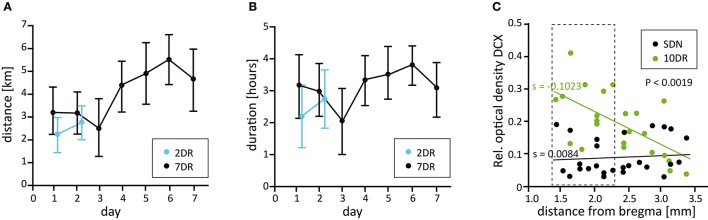
Running parameters and analysis of neurogenesis along the septotemporal axis. (A) Mean daily running distance of the 2 day (2DR, blue, N = 14) and the 7 day running groups (7DR, black, N = 18). Values are given as mean ± 95% confidence interval (CI). (B) Mean daily running duration for the 2DR (blue) and 7DR groups (black, mean ± 95% CI). (C) Densitometric analysis of DCX immunolabeling along the septotemporal axis for sedentary (SDN) and a preliminary 10 day running group (10DR, green, N = 4 mice each) with respect to distance from bregma. Linear regression analysis reveals a significant increase of neurogenesis in the 10DR group (slopes SDN s = 0.0084, 10DR s = −0.1023, p < 0.0019). Since the increase of newly born neurons was strongest in the dorsal hippocampus the area between 1.46 and 2.3 mm behind bregma was chosen for further analyses (dashed box).